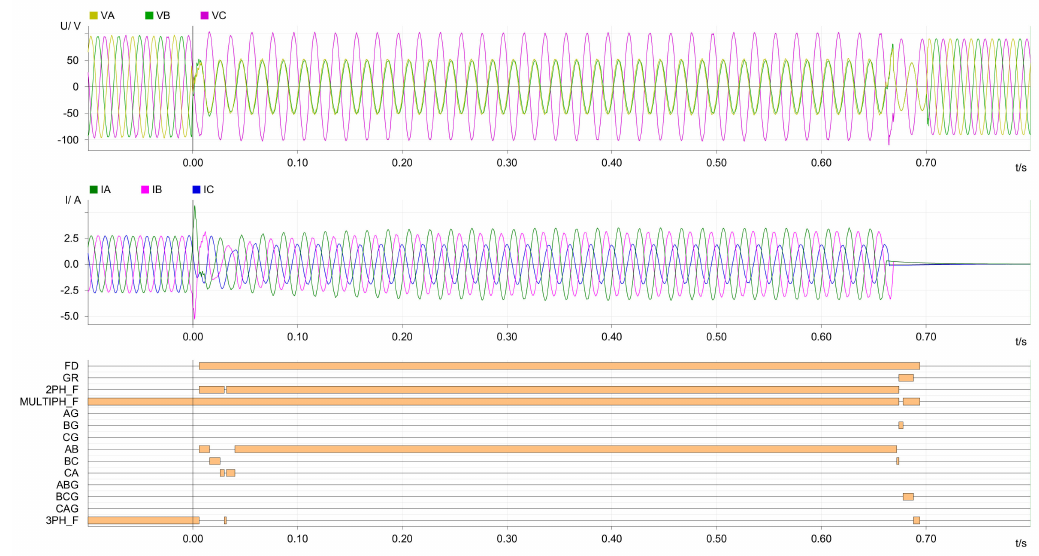
Figure 12. Faulted phase selector when AB fault is applied and K - factor = 2.5 using Strategy